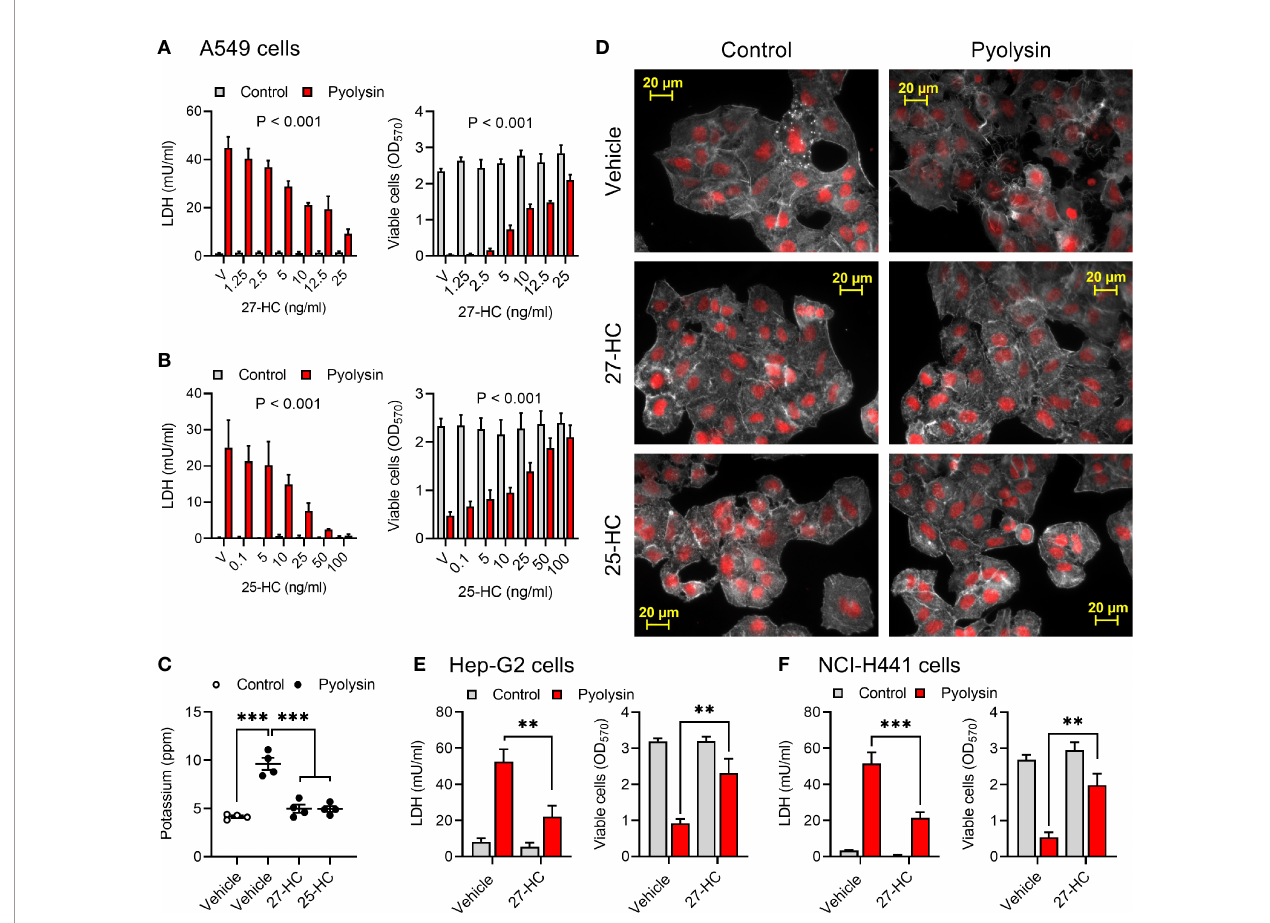
FIGURE 2 | Side-chain hydroxycholesterols protect epithelial cells against pyolysin. (A, B) A549 cells were cultured for 24 h in serum-free medium with vehicle (V) or the indicated concentrations of (A) 27-hydroxycholesterol or (B) 25-hydroxycholesterol, and then challenged for 2 h with control serum-free medium ( ■ ) or 25 HU pyolysin ( ■ ). The leakage of LDH was measured in cell supernatants and viable cells were determined by MTT assay. Data are presented as mean + s.e.m. from 4 independent experiments. Data were analyzed by ANOVA and P values reported for the treatment effect on pyolysin challenge. (C) Leakage of potassium from A549 cells cultured for 24 h in serum-free medium with vehicle, 25 ng/ml 27-hydroxycholesterol or 50 ng/ml 25-hydroxycholesterol, and then challenged for 5 min with control serum-free medium ( ○ ) or 25 HU pyolysin ( ● ). Extracellular potassium was measured in supernatants by fl ame photometry. Data are presented as mean ± s.e.m. with dots representing values from 4 independent experiments; data were analyzed by ANOVA with Dunnett ’ s post hoc test, ***P < 0.001. (D) Fluorescent microscope images of A549 cells cultured for 24 h in serum-free medium with vehicle, 10 ng/ml 27-HC or 10 ng/ml 25-HC, and then challenged for 2 h with control serum-free medium or pyolysin. Cells were stained with Alexa Fluor 555-conjugated phalloidin to visualize F-actin (white) and fl uorescent microscope images collected (nuclei are red, scale bars are 20 m m); images are representative of 3 experiments. (E) Hep-G2 liver cells and (F) NCI-H441 normal lung cells were cultured for 24 h in serum-free medium with vehicle or 10 ng/ml 27-hydroxycholesterol, and then challenged for 2 h control serum-free medium ( ■ ) or pyolysin ( ■ ; Hep-G2, 100 HU; NCI-H441, 200 HU). The leakage of LDH was measured in cell supernatants and viable cells were determined by MTT assay. Data were analyzed by ANOVA with Tukey ’ s post hoc test, ***P < 0.001,**P <